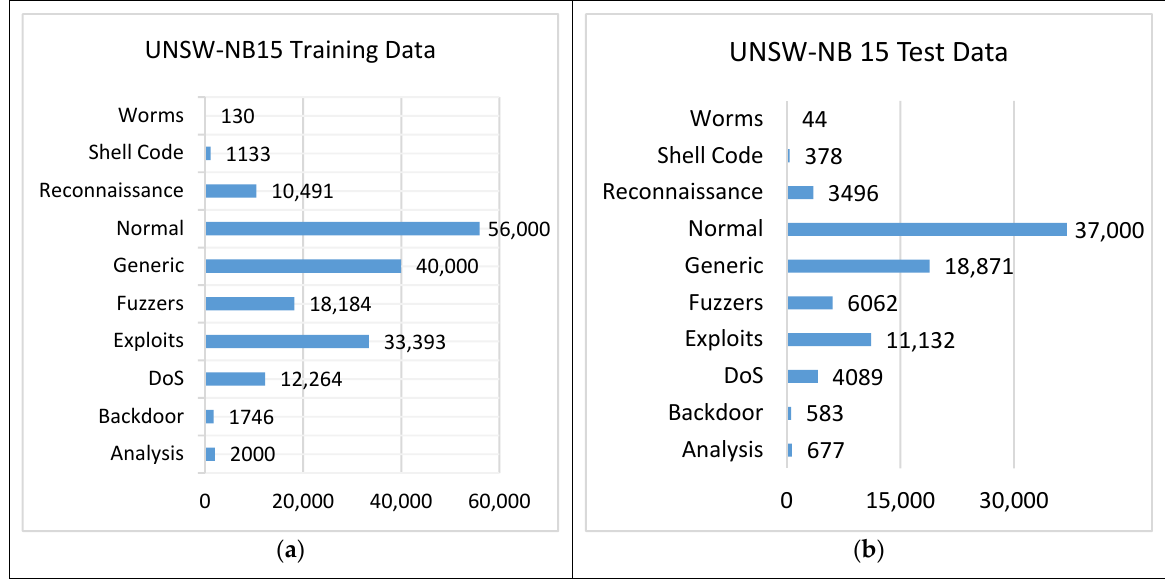
Figure 7. UNSW-NB15 ( a ) training data and ( b ) testing data.